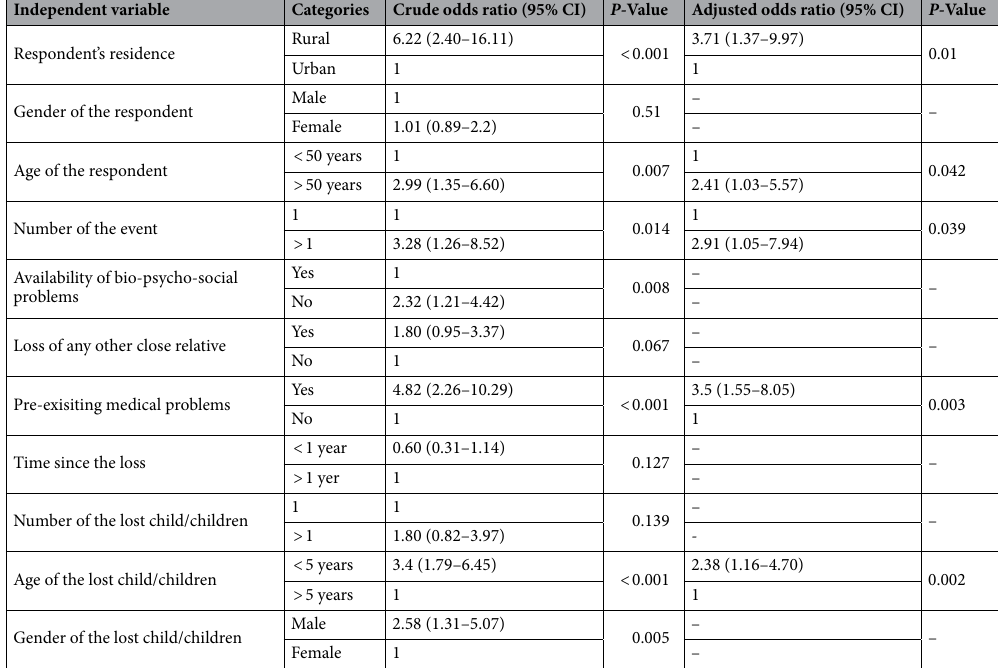
Table 3. Factors associated with odds of developing probable PTSD in bereaved parents who live in Kandahar Province, 2021; crude and adjusted odds